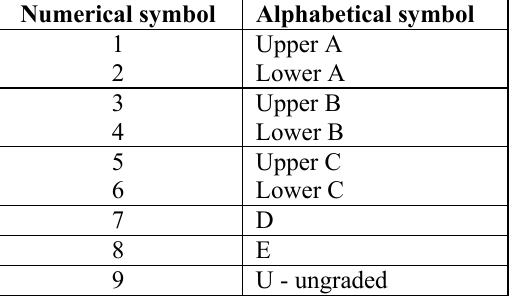
Table 1: The GCE O-Level grading system Numerical